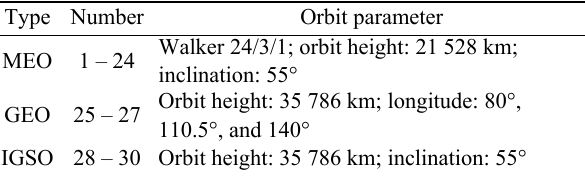
Table 1 Main parameters of the satellite constellation. Type Number Orbit parameter MEO